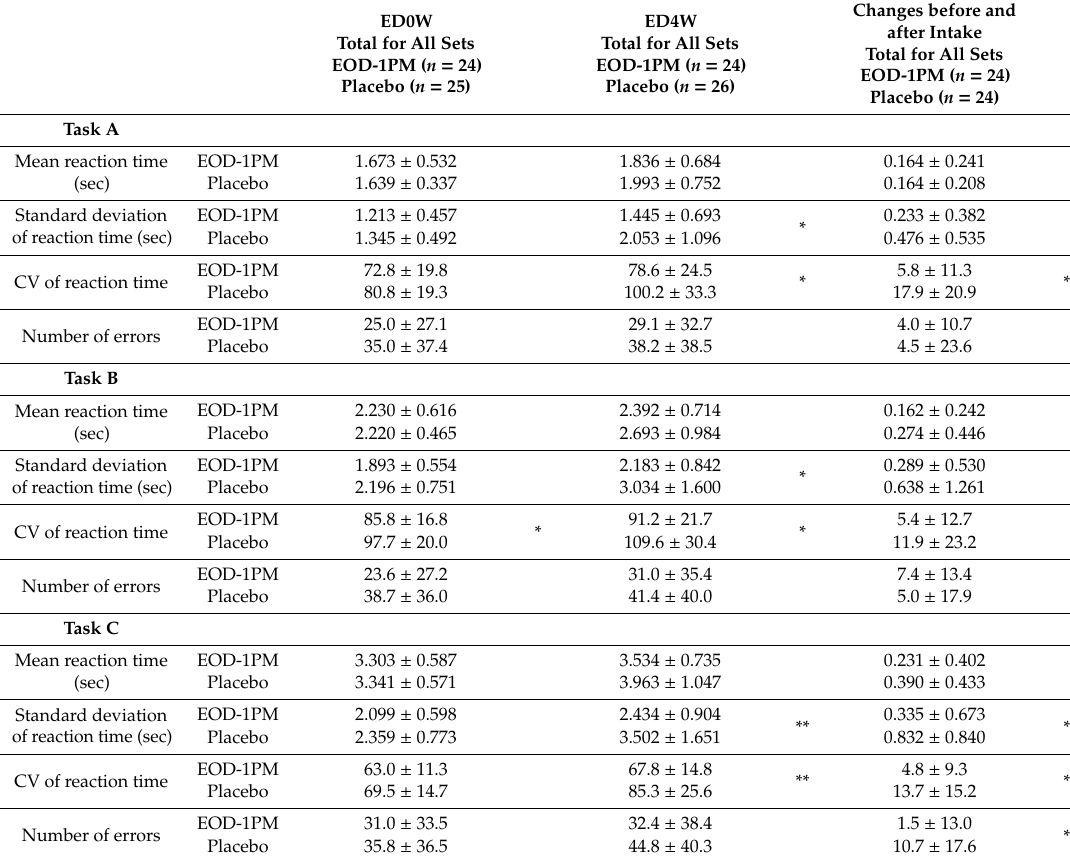
Table 4. Evaluation of work e ffi ciency by the